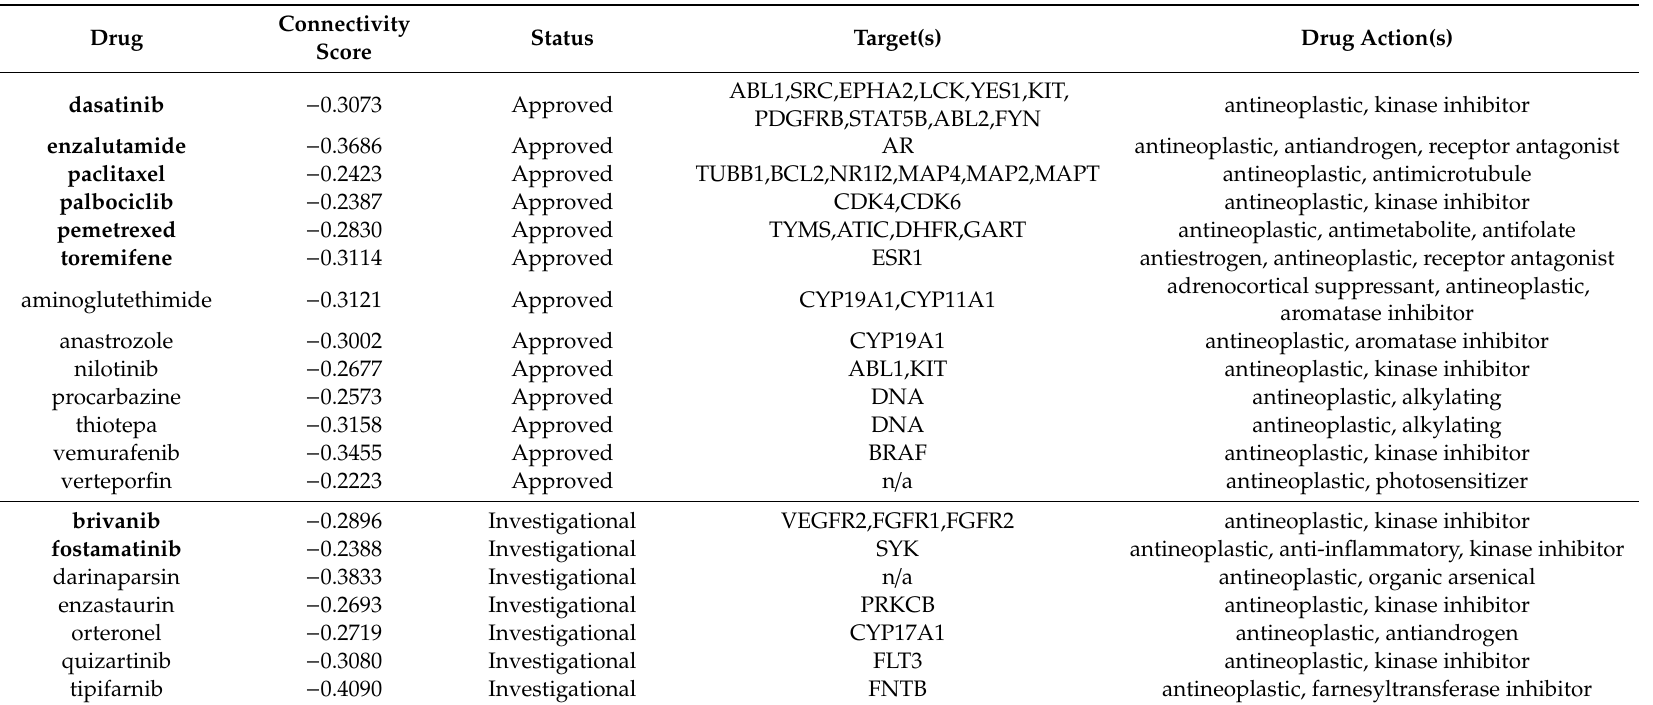
LINCS drug predictions were prioritized if they had negative connectivity scores in the HEPG2 cell line against the query sorafenib-resistant HCC gene signatures, a known approval or investigational status from the DrugBank and / or ClinicalTrials.gov databases, and antineoplastic function described in the KEGG Drug and DrugBank databases. Drugs in bold font targeted genes known to play a role in HCC from a systematic analysis of the biomedical